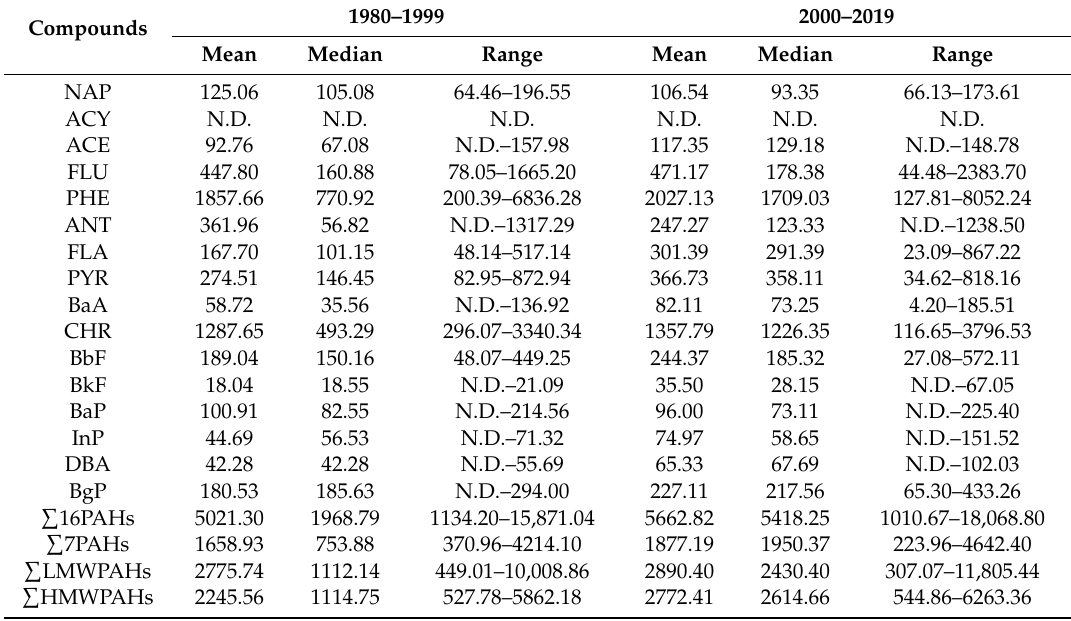
Table 1. Concentration profiles of PAHs in soil samples ( µ g kg − 1